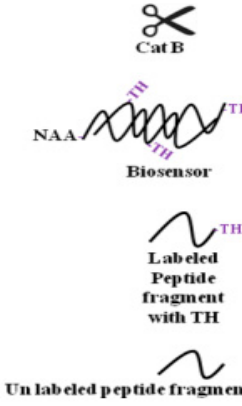
Figure 11. Schematic representation for the sensing mechanisms of cathepsin B (Cat B).